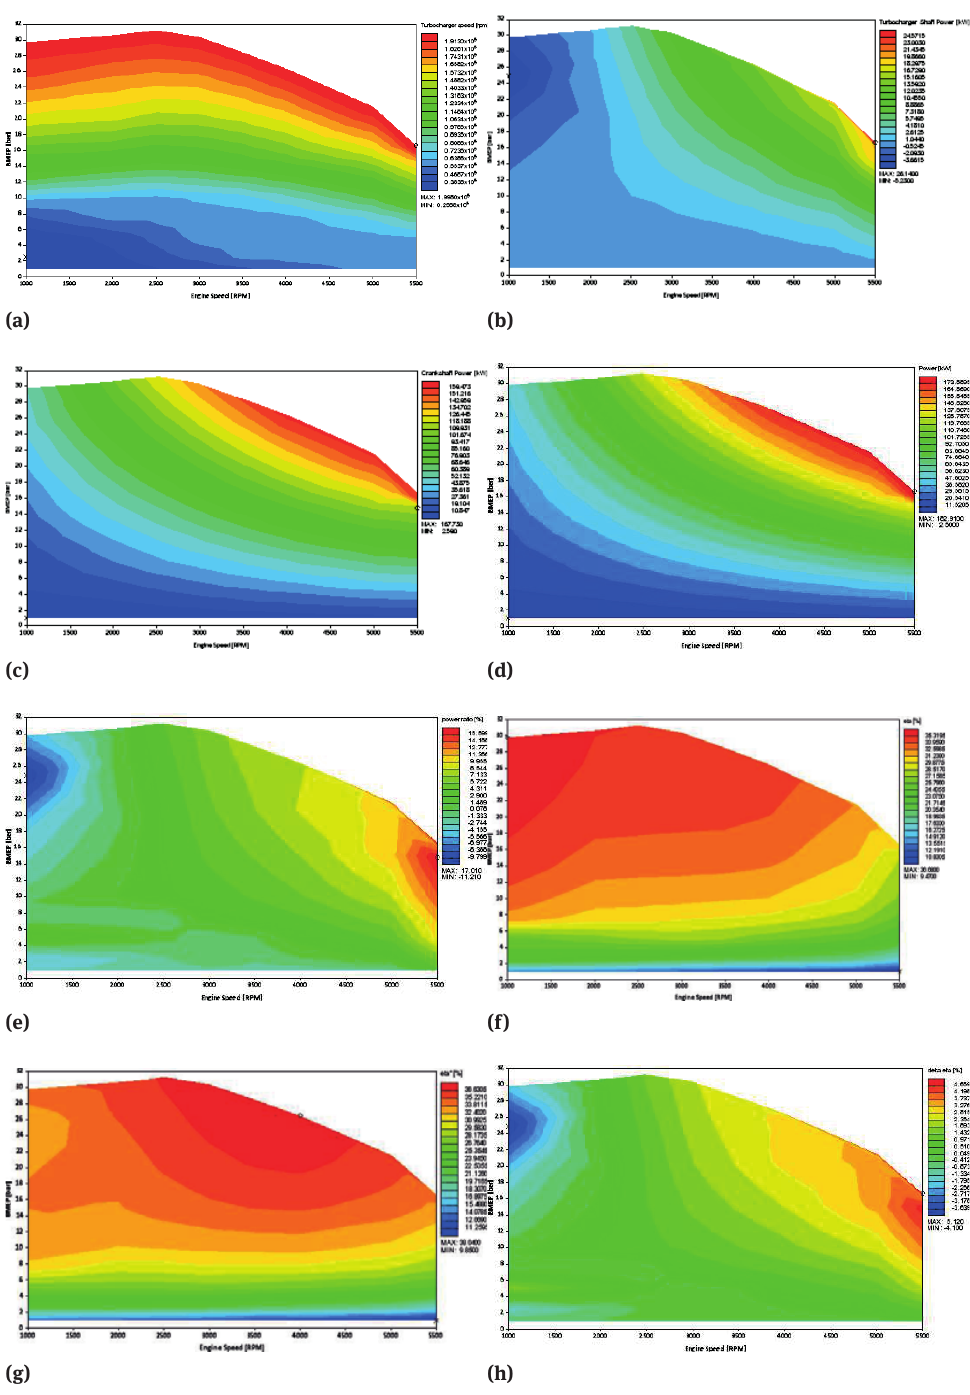
Fig. 5: Computed performance parameters vs. engine brake mean effective pressure (BMEP) and speed. a) turbocharger speed. b) power at the turbocharger shaft. c) power at the engine crankshaft. d) power at the turbocharger shaft and the engine crankshaft. e) power at the turbocharger shaft to the power at the engine crankshaft. f) efficiency η defined as the ratio of the engine crankshaft power to the fuel flow power. g) efficiency η *, defined as the ratio of engine crankshaft power plus the turbocharger shaft power to the fuel flow power. h) difference in between the two efficiencies η * − η